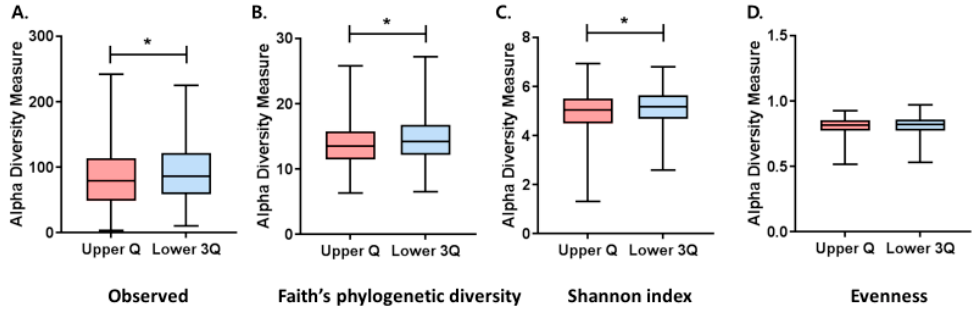
Figure 2. Comparison of alpha diversity indexes between the upper and lower three quartiles groups. ( A ) Observed amplicon sequence variants (ASVs), ( B ) phylogenetic diversity, ( C ) Pielou evenness, and ( D ) Shannon’s index. Lower 3Q, <75th percentile for platelet count; Upper Q, ≥ 75th percentile for platelet count. * q < 0.05.